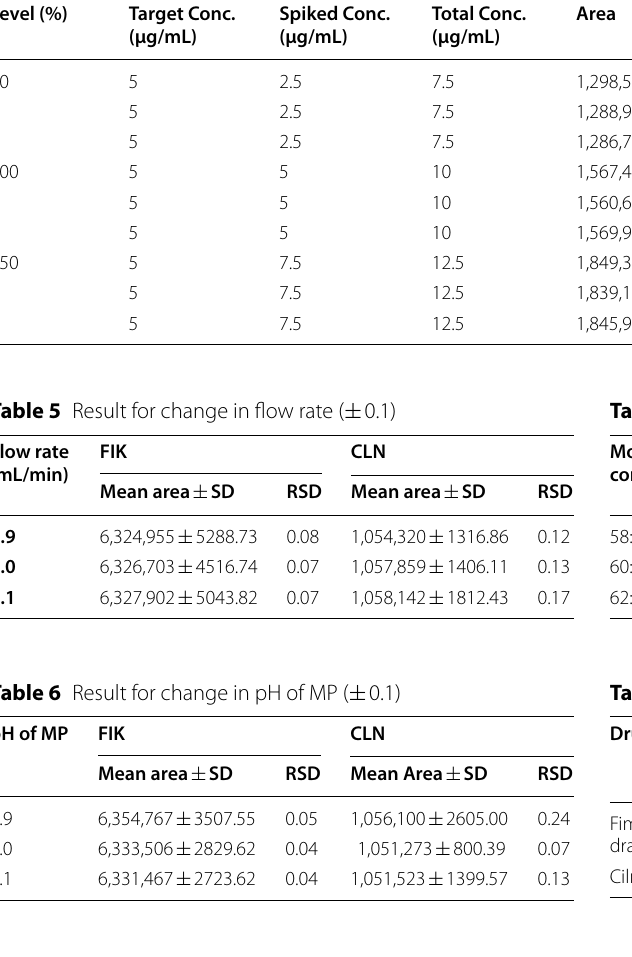
Table 4 Accuracy data for CLN